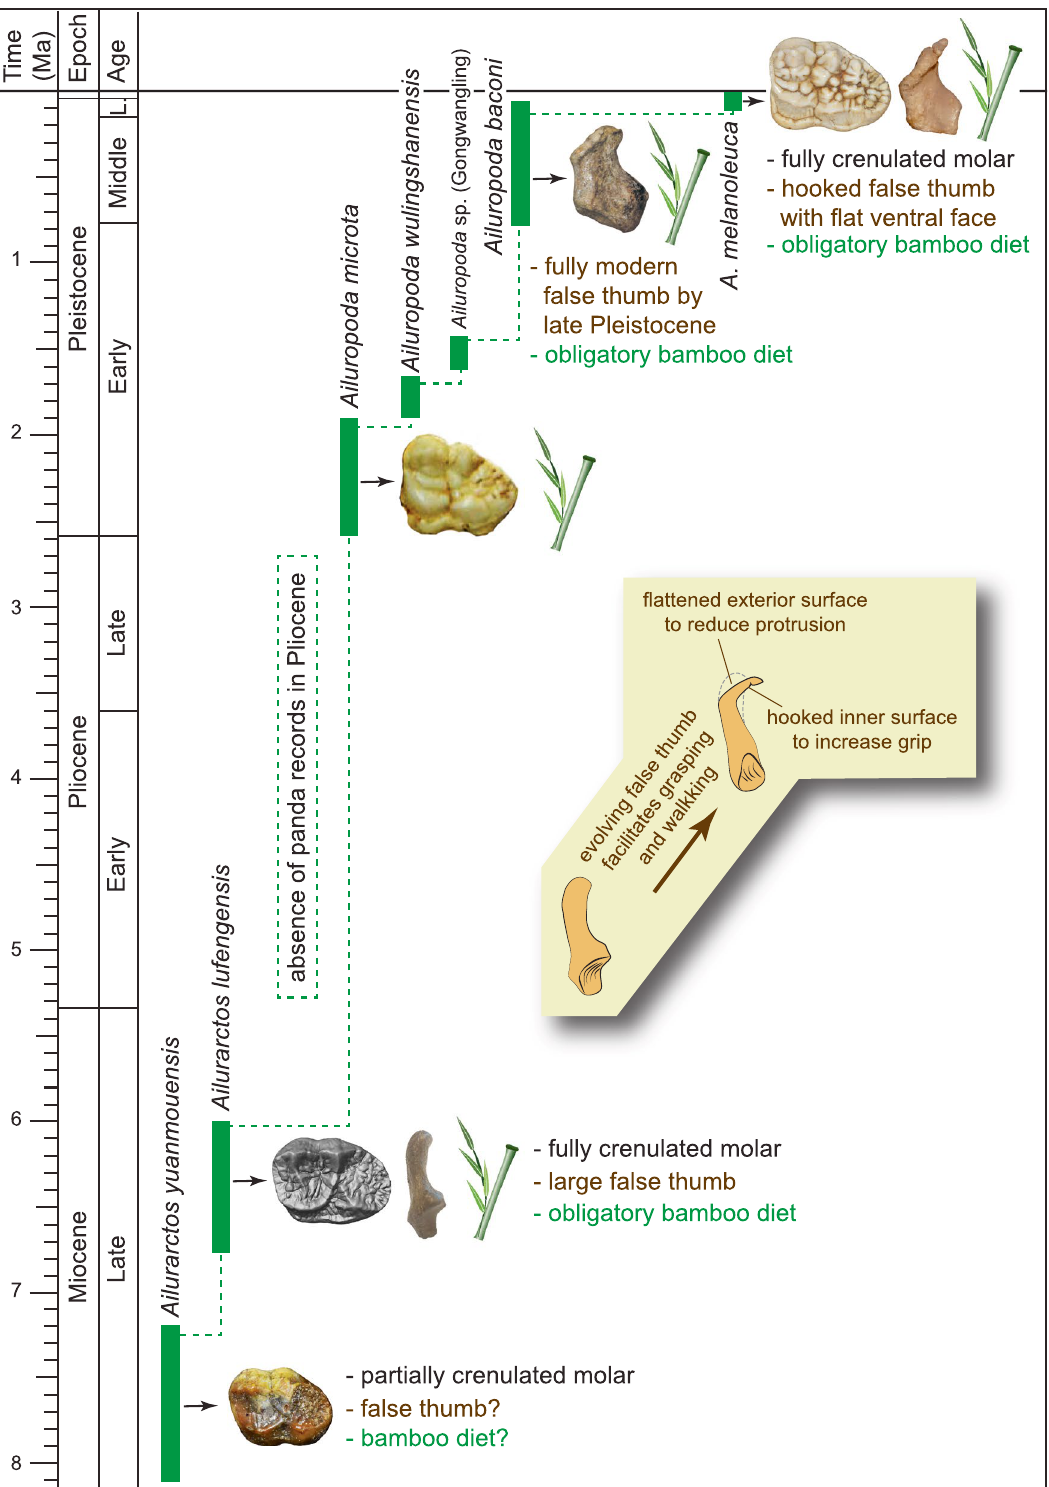
Figure 7. Phylogram of the giant panda showing the relevant steps discussed in the text and evolution of the false thumb. Pleistocene panda species ranges and chronospecies scheme follow Jin et al. 20 . The largest species, Ailuropoda baconi , was thought to be restricted to middle and late Pleistocene, with the modern species, A. melanoleuca , as Holocene 20 , although Sheng et al. 34 recognized the initial divergence of the living lineage in the late Pleistocene. The false thumb from late Pleistocene Shuanghe Cave was adopted from Wang et al. 10 , which was referred to A. melanoleuca . A major hiatus exists in the Pliocene, likely reflecting poor Pliocene records in South China. Chronology of Lufeng and Yuanmou faunas is based on Dong and Qi 33